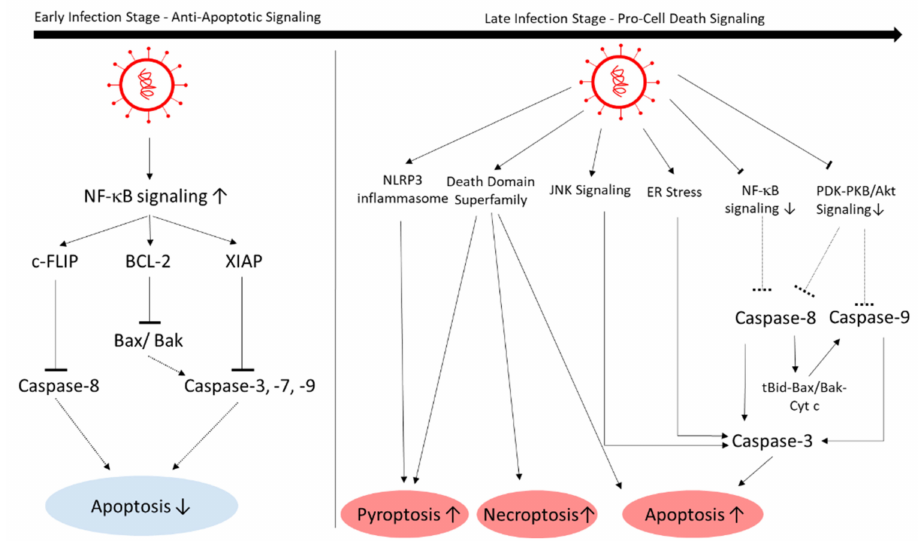
Figure 7. SARS-CoV-2 manipulates cell death. In early infection stages, cell death is inhibited to promote viral replication, while in later infection stages, cell death is promoted to enhance vi- ral spread. The dotted arrows indicate a decreased effect through viral effect. C-FLIP, cellular FLICE (FADD-like IL-1 β -converting enzyme)-inhibitory protein; BCL-2, B-cell lymphoma 2; XIAP, X-linked inhibitor of apoptosis protein, Bax, Bcl-2-associated X protein, Bak, BCL-2 antagonist/killer- 1; ER, endoplasmic reticulum; JNK, c-Jun N-terminal kinase; NF- κ B, nuclear factor- κ B; PDK, 3- phosphoinositide-dependent kinase; PKB/Akt, serine/threonine kinase protein kinase B; tBid, trun- cated BH3 interacting-domain death agonist; Cyt c, cytochrome c; NLRP3, NLR family pyrin domain containing